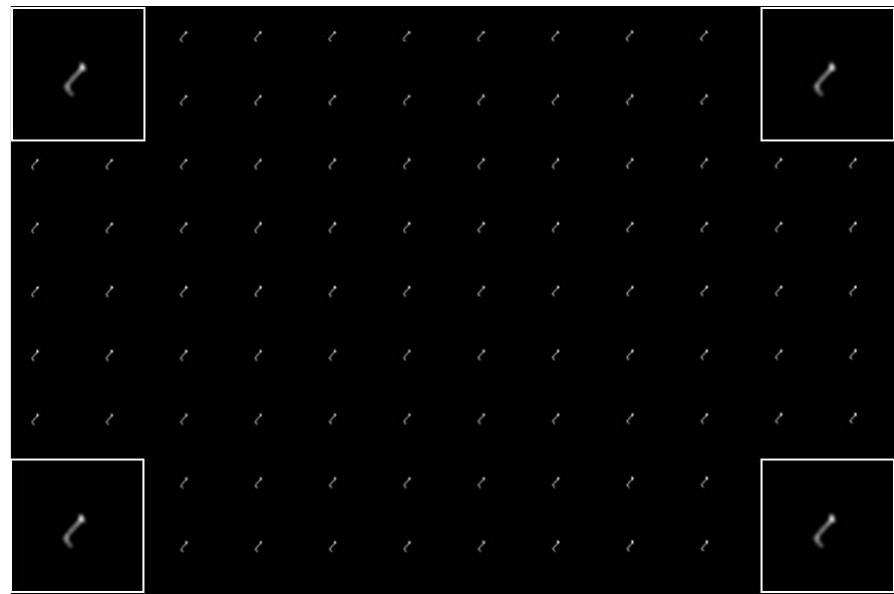
Figure 3. Ground-truth blur kernel.